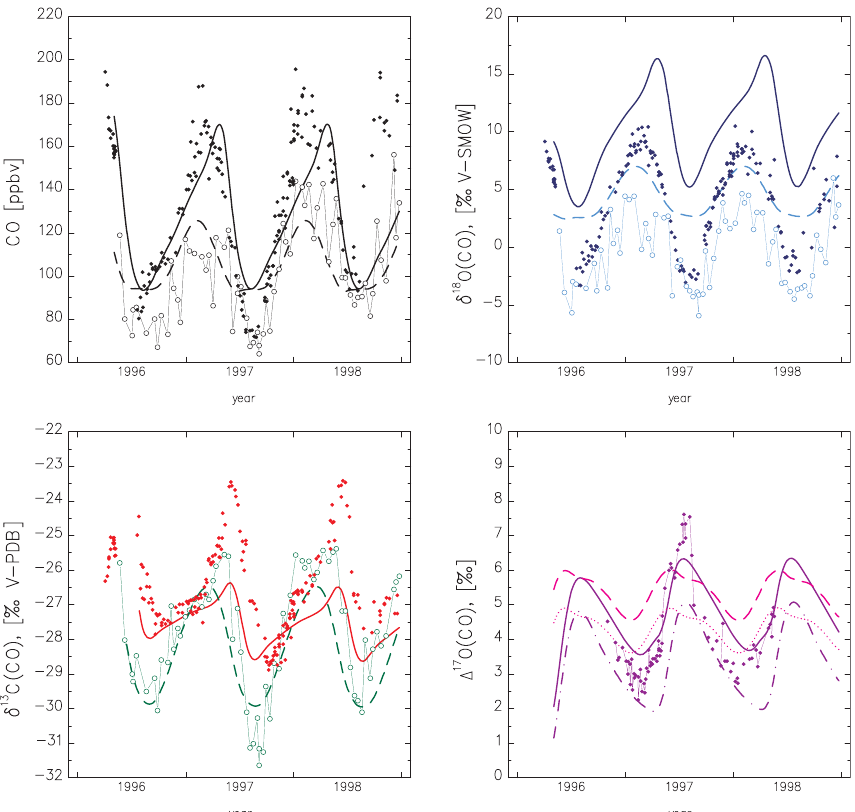
Fig. 5. Simulated CO mixing ratio and isotopic composition in the box. Solid and dashed lines refer to the HL and LL box setups, respectively (see text). Symbols denote the observations (Gros et al., 2001; R¨ockmann et al., 2002) for CO for high (80 ◦ N, filled symbols) and low latitudes (30 ◦ N, open symbols). The lower right panel presents the mass-independent fractionation signal ( 1 17 O) in CO and additional results of the mass-dependently fractionated O 3 setup for high latitude (dash-dotted line) and low latitude (dotted line)